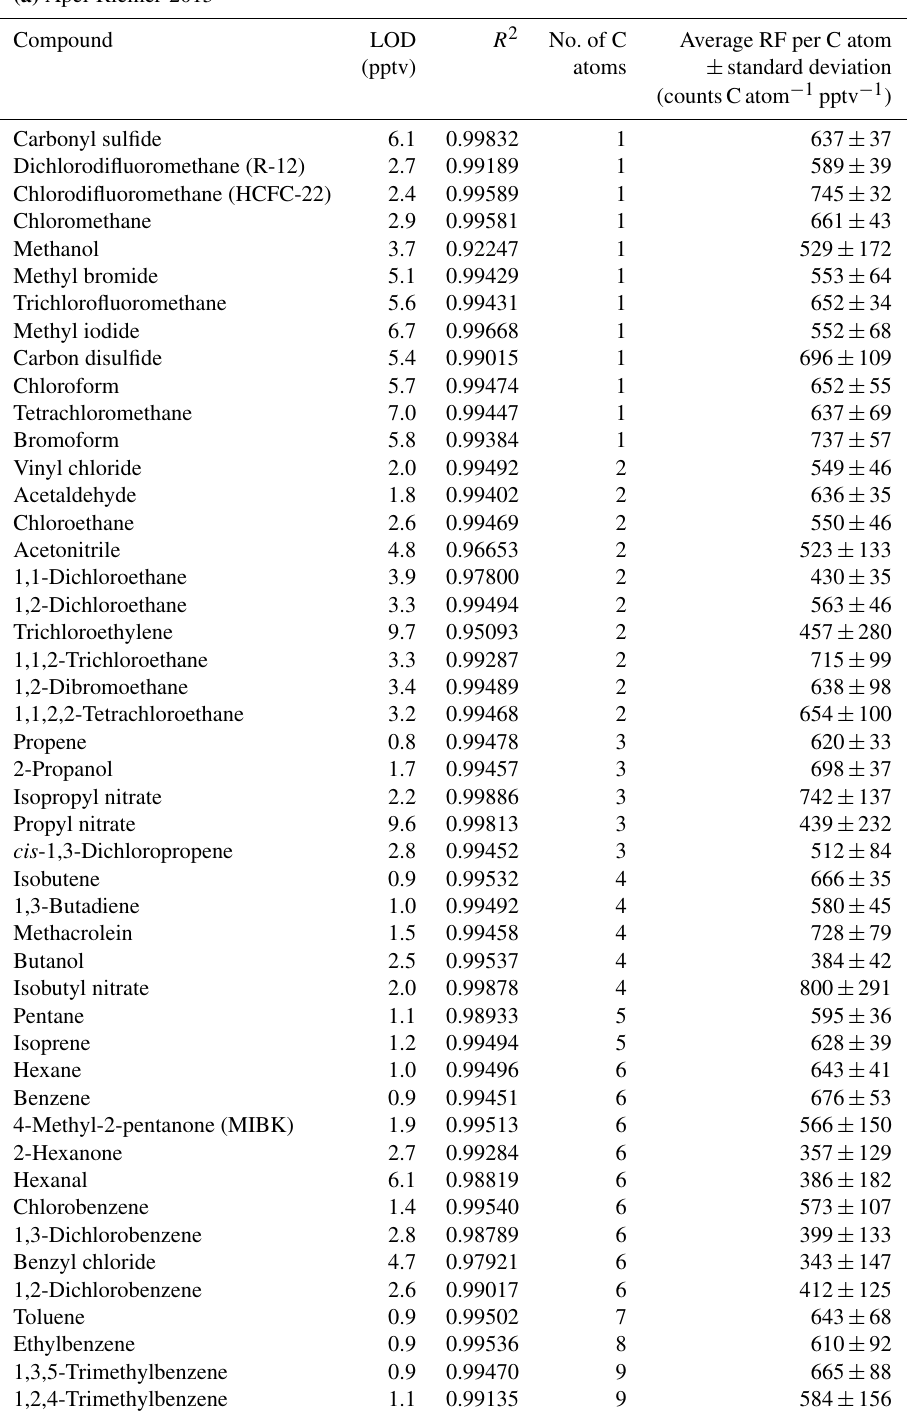
Table 1. CryoTrap–GC–AED system limits of detection (LODs) at the 3 σ level, R 2 linearity, and average response factors (RFs) per carbon atom value derived from (a) Apel-Riemer-2015 and (b) NPL-2017 gas calibration standard measurements ± standard deviation at the 1 σ